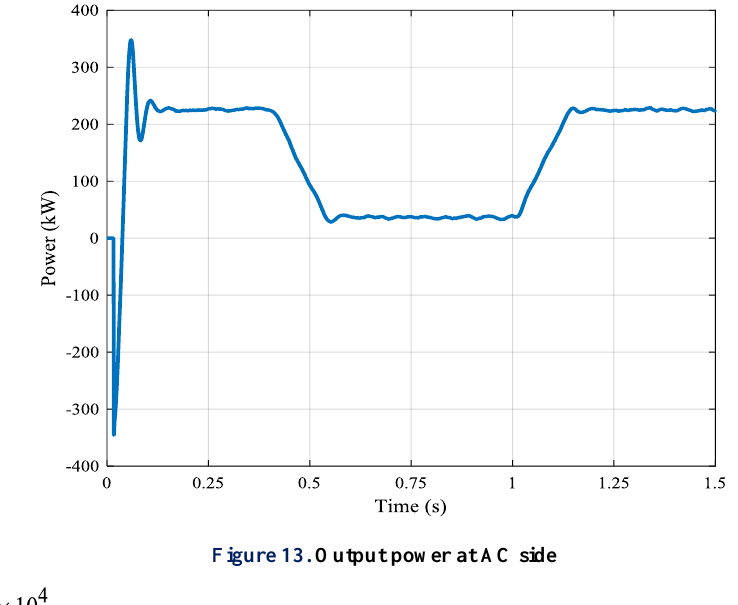
Figure 13. Output power at AC side